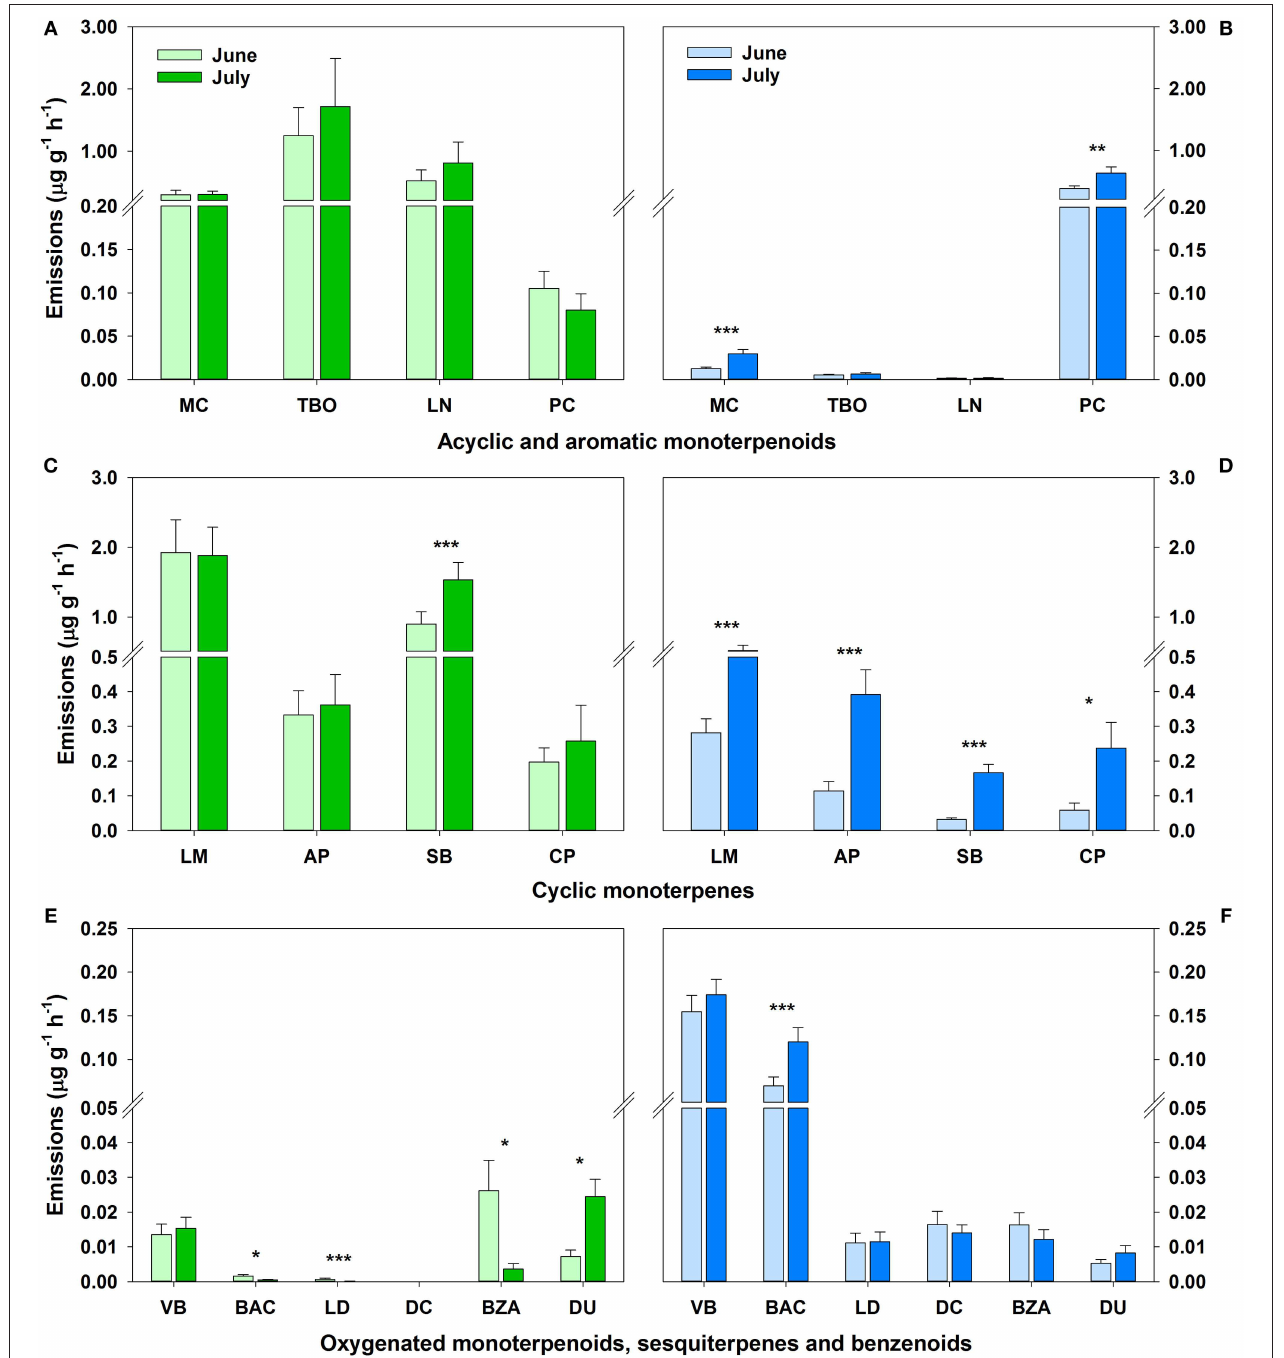
FIGURE 2 | Emissions of selected BVOCs with standard error for acyclic and aromatic monoterpenoids (A,B) , cyclic monoterpenes (C,D) , and oxygenated monoterpenoids, sesquiterpenes and benzenoids (E,F) for Q. suber (green, n = 59 in June, n = 60 in July, A,C,E ) and C. ladanifer (blue, n = 24 in June, n = 30 in July, B,D,F ) for June and July. Due to a high variability of emission rates between BVOCs, data breaks (//) were introduced for a better overview. Significant changes (Wilcoxon signed rank test) in emission rates between months are indicated by asterisk over bars at a significance level of * p < 0.05, ** p < 0.01, *** p < 0.001. MC, myrcene; TBO, trans- β -ocimene; LN, linalool; PC, p-cymene; LM, limonene; AP, α -pinene; SB, sabinene; CP, camphene; VB, verbenone; BAC, bornyl acetate; LD, ledene; DC, δ -cadinene; BZA, benzaldehyde; DU, durene. DC was not detected in emissions of Q. suber .